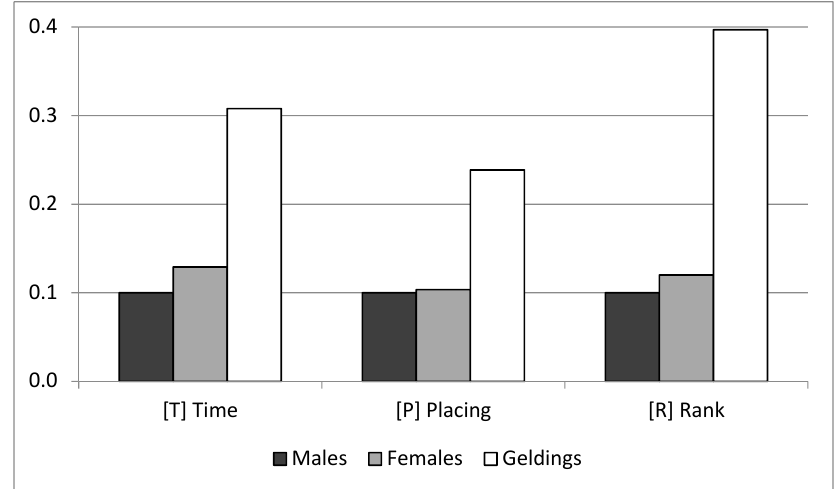
Figure 3. Means of the marginal posterior distributions for the levels of the sex effect for Race Time, Placing and Rank traits, transformed to positive scale, with the minimum fixed to 0.1.